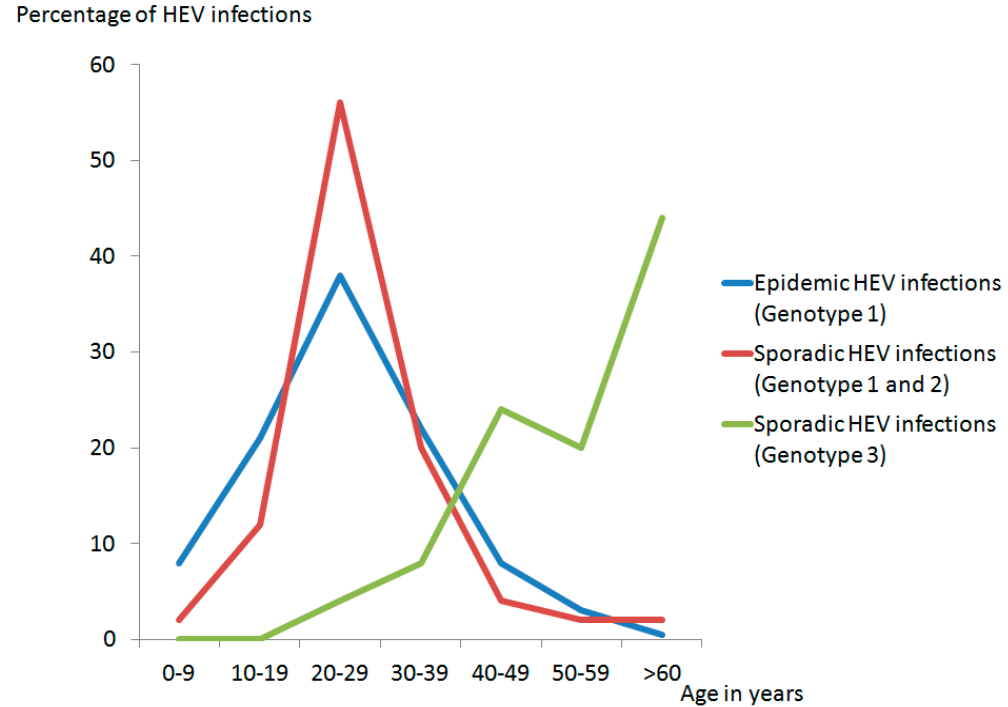
Figure 3. Distribution of HEV infections in different age groups (based on: Purcell and Emerson [61]).